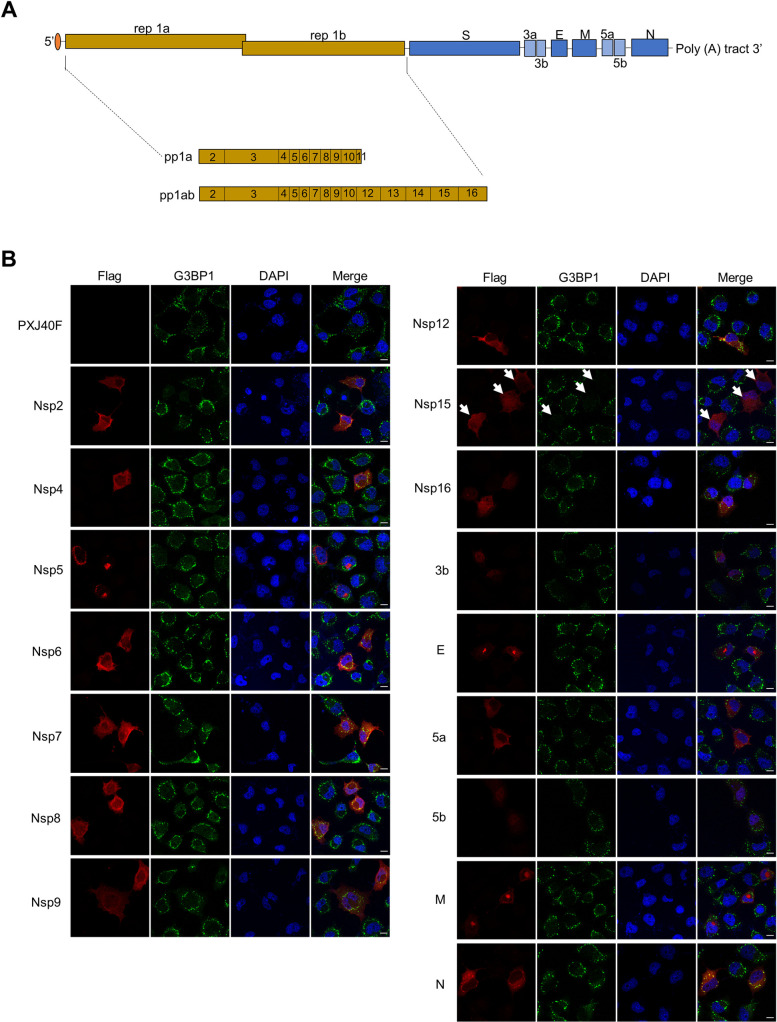
IBV nsp15 inhibits the formation of SGs.(A) Schematic diagram of the proteins encoded by IBV. (B) H1299 cells were transfected with plasmids encoding Flag-tagged IBV proteins or with vector PXJ40F. At 24 h post-transfection, cells received heat shock treatment at 50°C for 20 min. IBV proteins were stained with anti-Flag antibody (red) and SGs were detected with anti-G3BP1 (green). Cell nuclei were stained with DAPI (blue). The representative images of three independent experiments were shown. Scale bars: 10 μm.